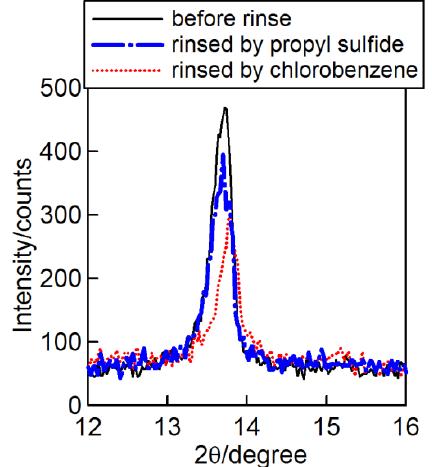
Figure 1. XRD patterns of one-step-processed CH 3 NH 3 PbI 3 perovskite layers varied by solvent rinsing on the perovskite